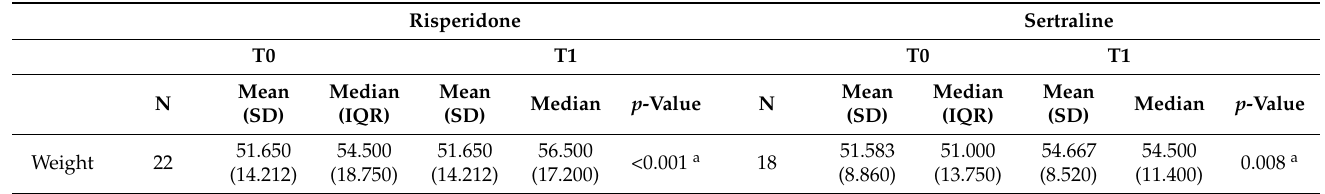
Table 3. Paired comparisons between T0 and T1 of both risperidone and